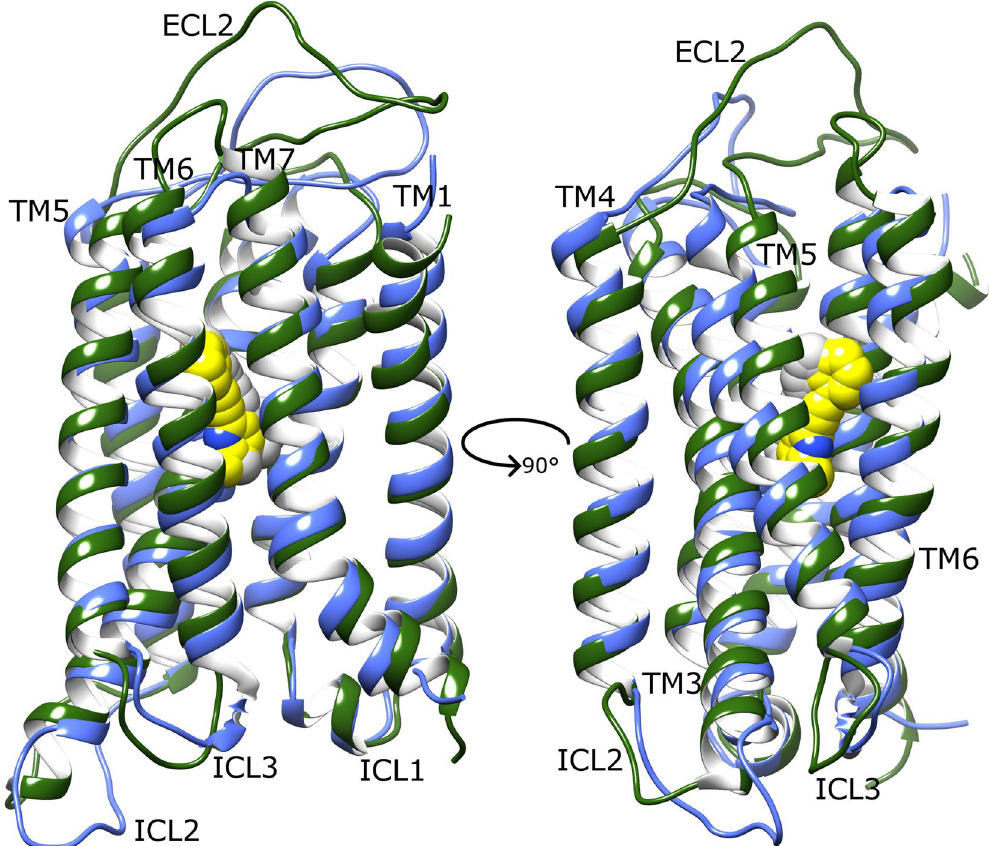
Figure 9. Comparison of average conformations of ( A ) mGlu4 with bound with MPEP (dark green, yellow, respectively) and mGlu5 bound with MPEP (blue, grey, respectively), obtained from 2.5–5 µ s of respective MD simulations. Receptors are viewed from side, within membrane, with a 90° rotation around membrane plane for alternative views (left and right images). Relevant structural features are labelled, i.e. intracellular loops (ICLs) and transmembrane helices